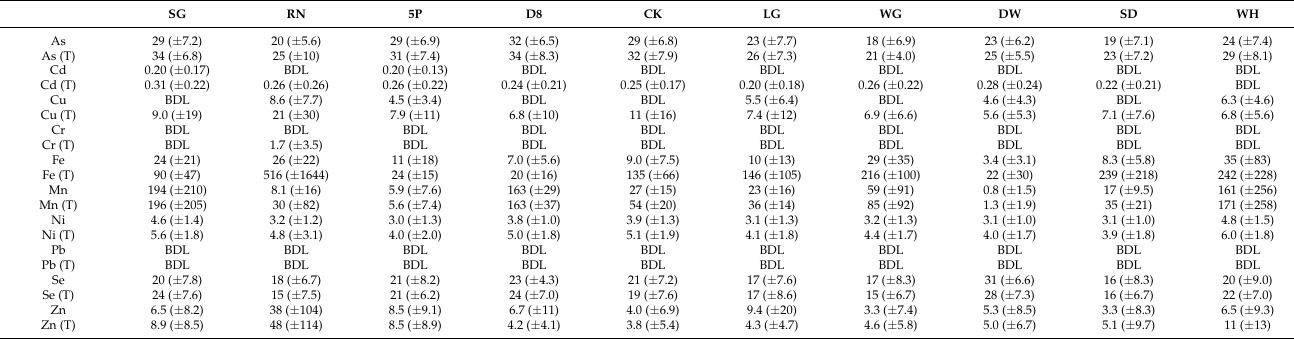
Table 7. Mean dissolved and total metals concentration values for each site and standard deviation. Results are reported in µ g/L.